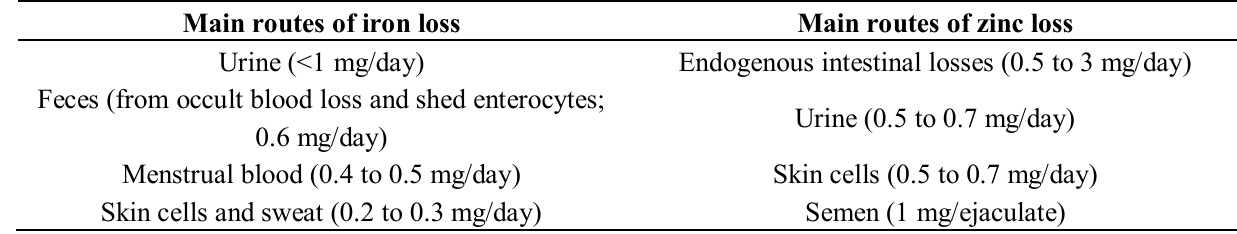
Table 5. Main routes of iron and zinc